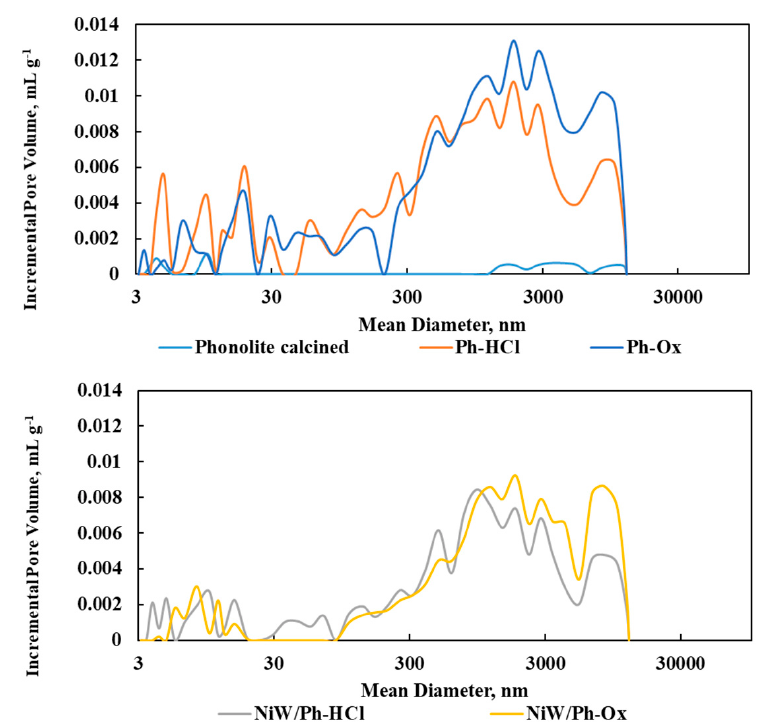
Figure 1. Hg porosimetry of the original phonolite material and its derived